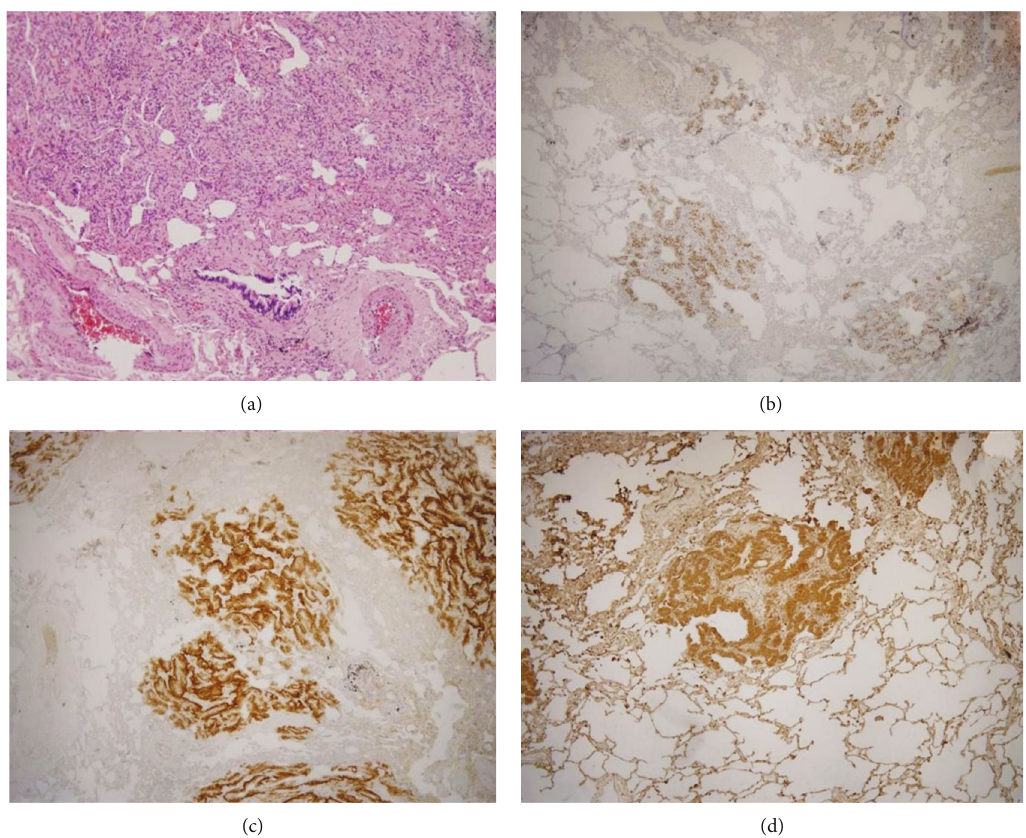
Figure 2: Lung parenchyma with meningothelial cells that are solid trabecularly arranged and has a round to ovoid shape; in some places, they are fusiform (hematoxylin and eosin, 100x) (a). Immunohistochemical staining was positive for progesterone receptor (b), CD56 (c), and vimentin